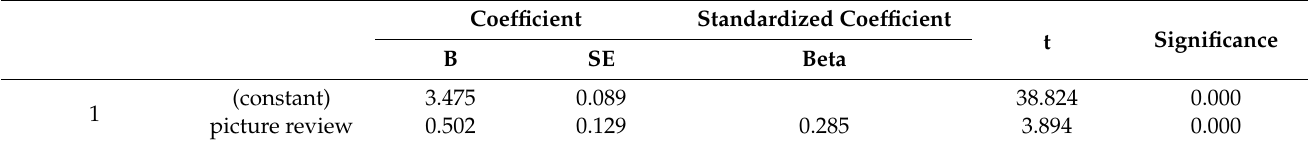
Table 15. Regression coefficients of Experiment A a